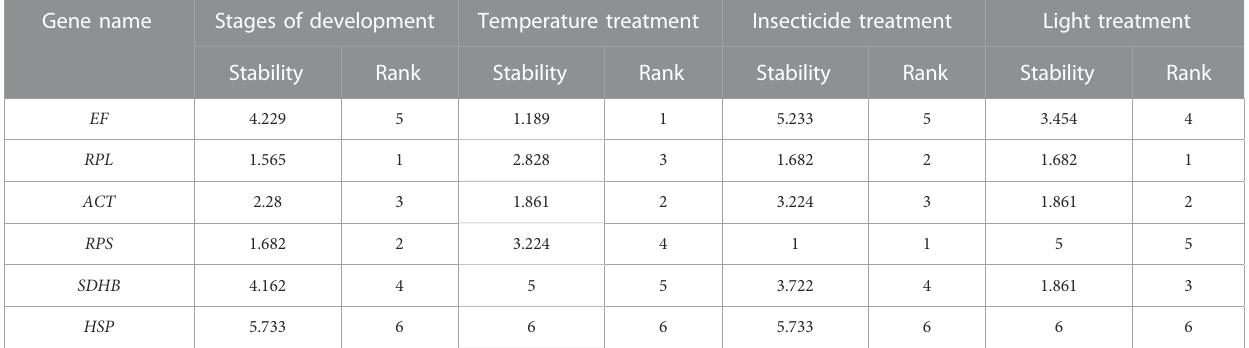
TABLE 3 Expression stability of the reference genes under different experimental